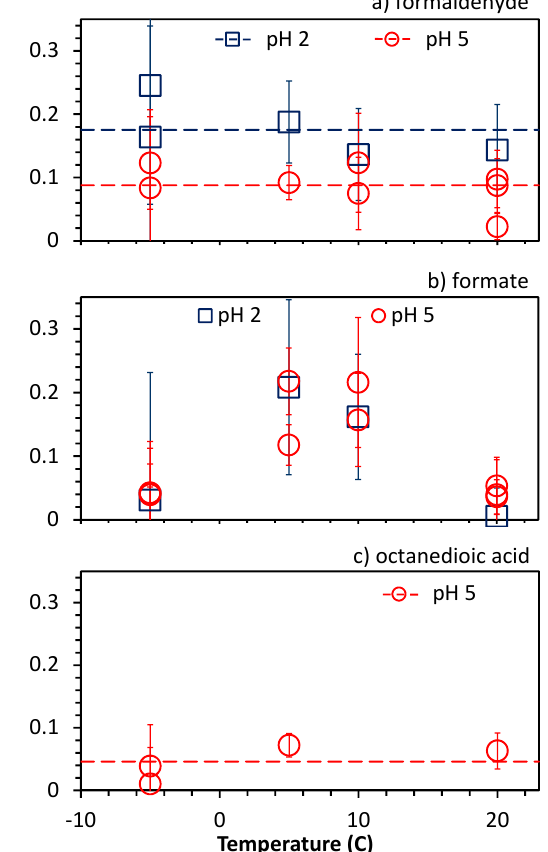
Fig. 6. Temperature dependence of the HOOH yield for three model compounds at pH 2 (blue squares) and pH 5 (red circles). The average HOOH yields (indicated by dashed horizontal lines) for formaldehyde were 0.18 (pH 2) and 0.088 (pH 5), while the av- erage yield for octanedioic acid is 0.046 (pH 5). Error bars are the net indeterminate error (propagated standard